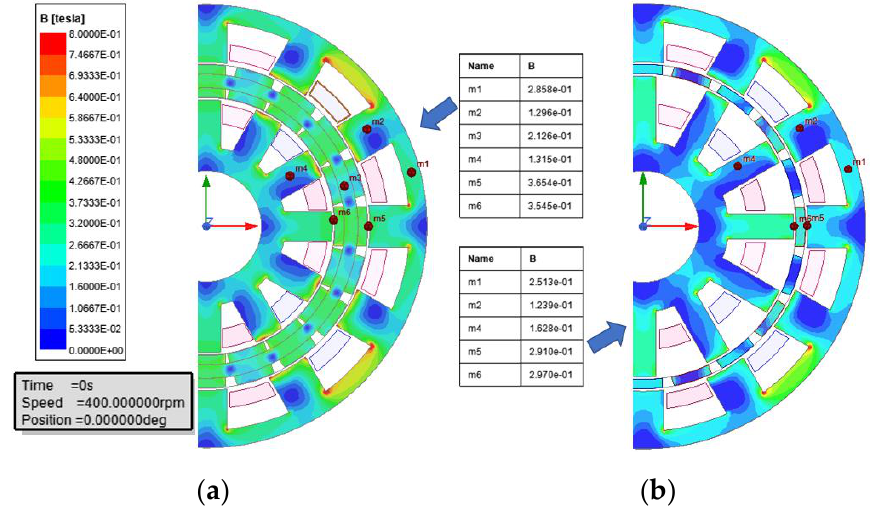
Figure 6. Flux densities comparison in DARF-PMVM at no-load: ( a ) with iron yoke rotor, ( b ) without iron yoke (yokeless) rotor.